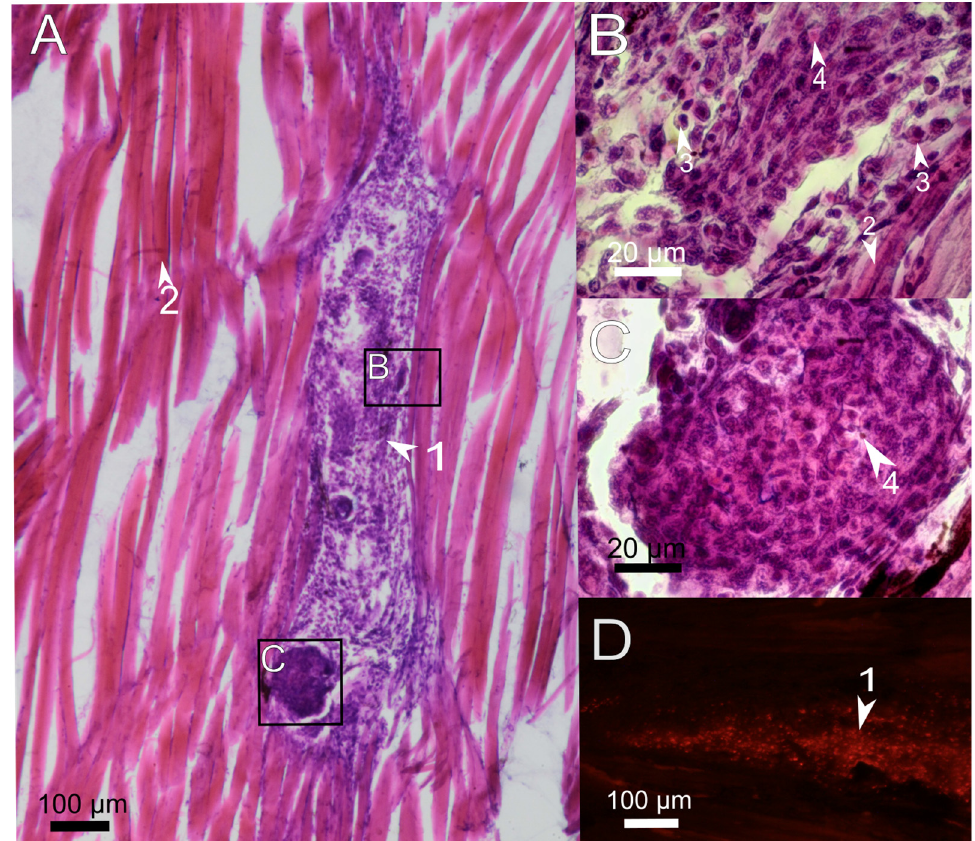
Figure 5. Sagittal histological section of D. rerio muscles 14 days after the injection of 2.7% PAAH + PMs. ( A ) histological section of the injection site (×10), H&E stain; ( B , C ) enlarged images of regions from A showing granulomas, which are dense agglomerations of phagocytic cells around remnants of PAAH. ( D ) fluorescence of the unstained histological section in the red channel indicates microcapsules loaded with SNARF-1. 1, PAAH + PMs; 2, muscle fibers; 3, eosinophilic granular cells; 4, fluorescent microcapsules.